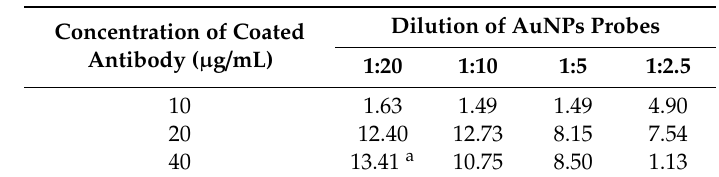
Table 1. The checkboard titration to determine the concentration of capture antibody and AuNP probes. Comparison of P/N values of the capture antibody with different concentrations and AuNP probes with different dilutions.